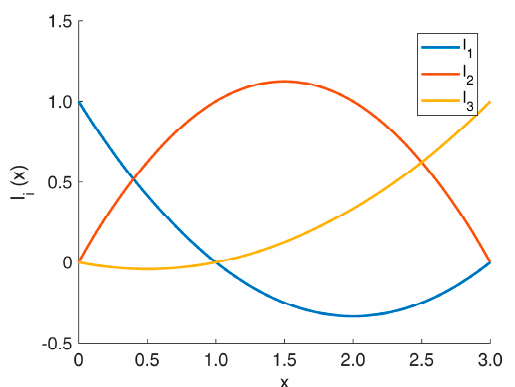
Figure 2. Lagrange basis functions for a parabola in the interval [0, 3] for the example x 0 = 0, x 1 = 1 1 x = and 3 x = . and x 2 = 1 2